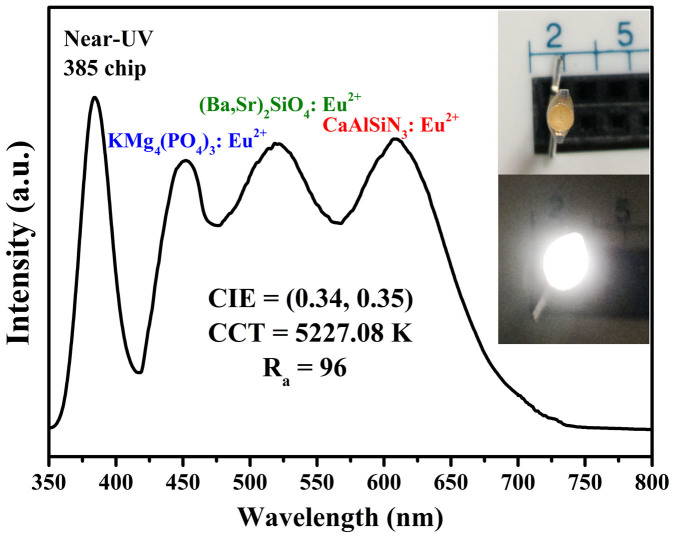
EL spectrum of a white-emitting N-UV-LED chip (385nm) comprising of KMg4(PO4)3:Eu2+ (blue), (Ba,Sr)2SiO4:Eu2+ (green) and CaAlSiN3:Eu2+ (red) phosphors driven by a 2mA current.